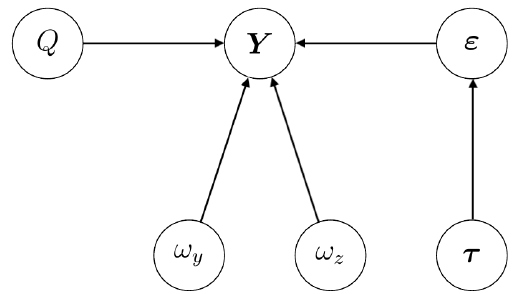
Figure 3. Directed acyclic graph showing the conditional depen- dence relationships between the data (enhancements) Y and the er- ror components ε (Sect. 4.1); the emission rate Q (Sect. 4.2); and the unknown parameters τ ,ω y , and ω z (Sect.